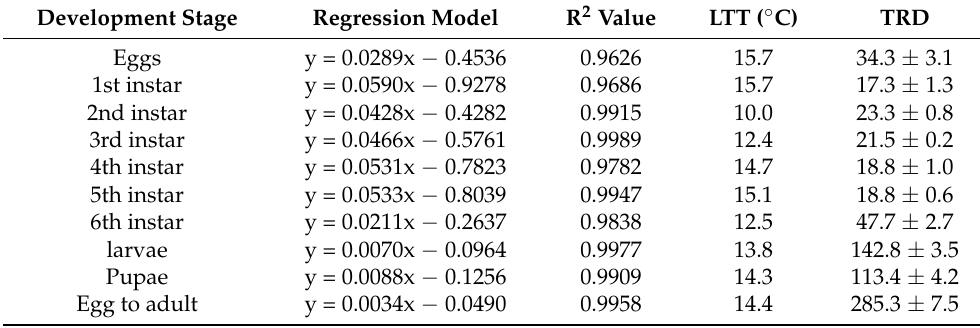
Table 2. Linear regression analysis, lower temperature threshold (LTT), and thermal requirement in degree-days (TRD) during the developmental stages of Spodoptera frugiperda according to temperature.